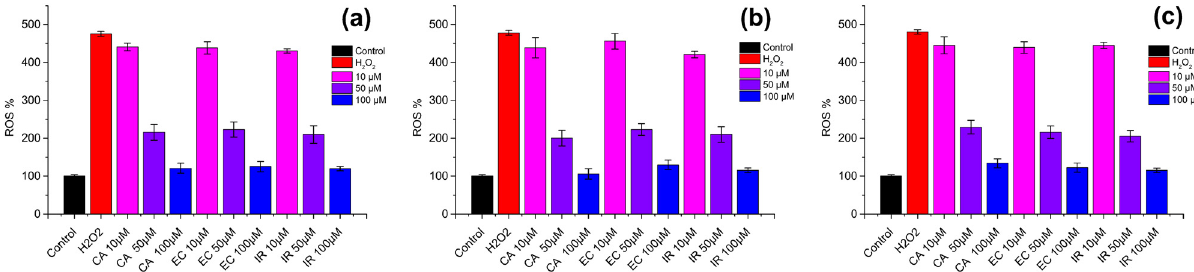
Figure 7: E ff ects of chlorogenic acid ( CA ) , echinacoside ( EC ) , and isorhamnetin - rutinoside ( IR ) on intracellular ROS levels of hydrogen peroxide - induced ( a ) LO2, ( b ) GES - 1, and ( c ) HUVEC cells.